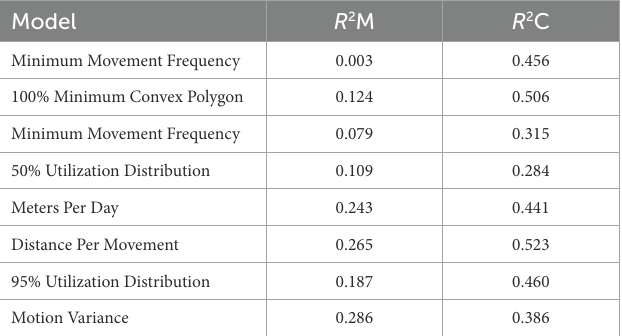
TABLE 3 Marginal and conditional R 2 for individual RT derived annual movement LME